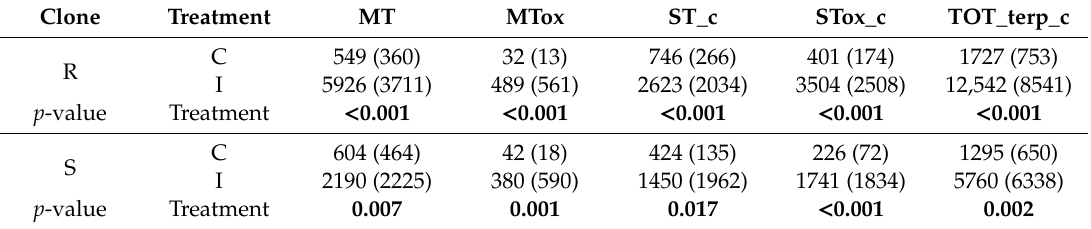
Table 4. GLMM of the concentration of terpenoids ( µ g / g) in the common cypress bark samples of the resistant (R) and susceptible (S) cypress clones comparing the control (C) vs. infected (I) treatments for the following variables: MT (monoterpenoids concentration), MTox (oxygenated monoterpenoids concentration), ST (sesquiterpenoids concentration), STox (oxygenated sesquiterpenoids concentration), TOTterp (total terpenoids concentration). The average and standard deviation (sd) for each variable are shown (N = 12). The p -value shows the significance of the fixed variables (treatment, C vs. I). Significant di ff erences ( > 95%) are highlighted in